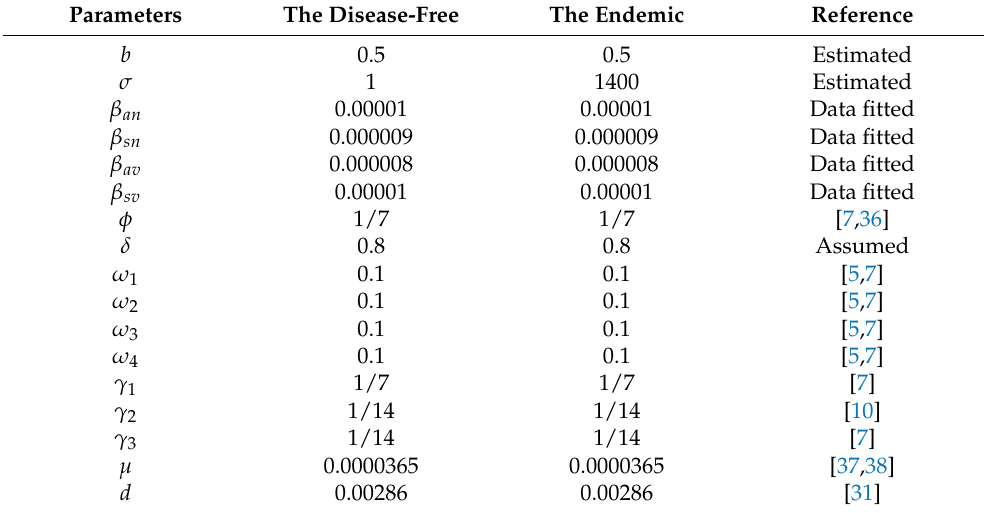
Table 2. The parameters used in the numerical